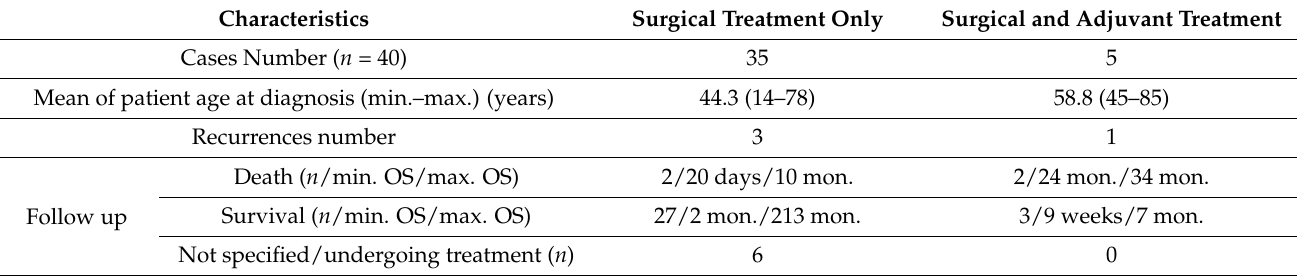
Table 4. Comparison of selected features between group treated with surgery only and group treated with surgery and adjuvant chemotherapy in primary carcinoid of the ovary. Characteristics Surgical Treatment Only Surgical and Adjuvant